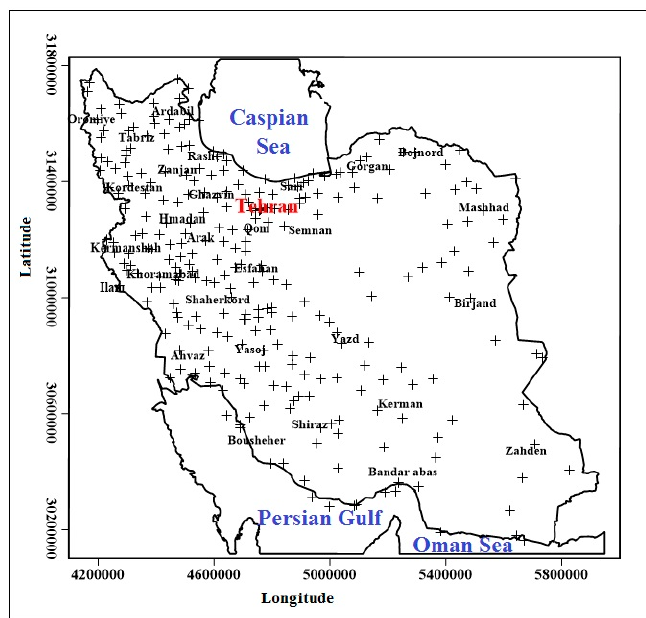
Figure 1. Distribution pattern of the studied stations.